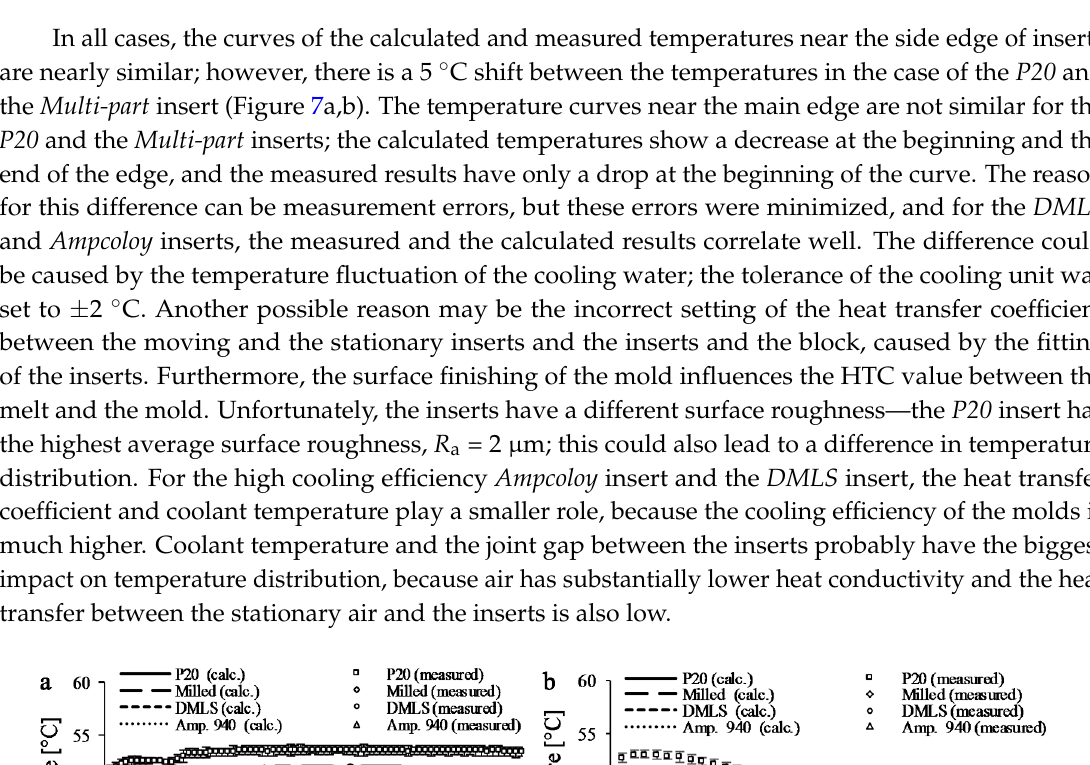
Figure 8. The temperature ramp of the Multi-part and P20 insert in the case of coolant temperature 42 °C. Main edge ( a ); side edge ( b ) . A new model was set up with air gaps between the side faces of the core and cavity inserts (Figure 9). The fitting gap between the two inserts was measured by applying a high viscosity polymer liquid (dynamic viscosity around 600 Pas at room temperature), which provides an adequate contact surface between the inserts. The gap was found to be 0.1 ± 0.02 mm. The modeled gap has the thermal